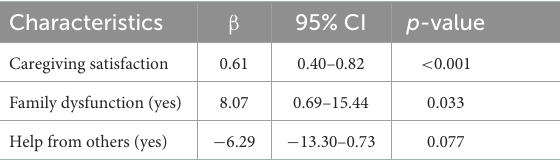
TABLE 4 Factors associated with the burden of caregivers. Palmas, Tocantins, Brazil, 2020–2022 ( n = 52).